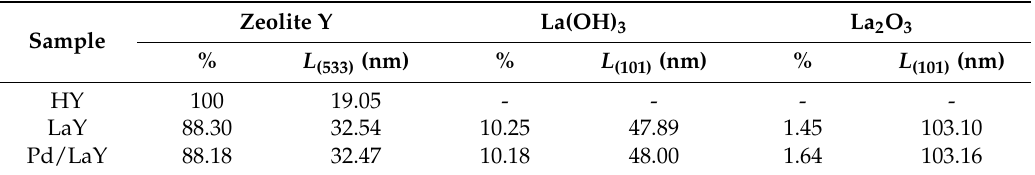
Table 1. Average crystallite sizes and relative percentages of the crystalline phases of the HY zeolite, LaY and Pd/LaY